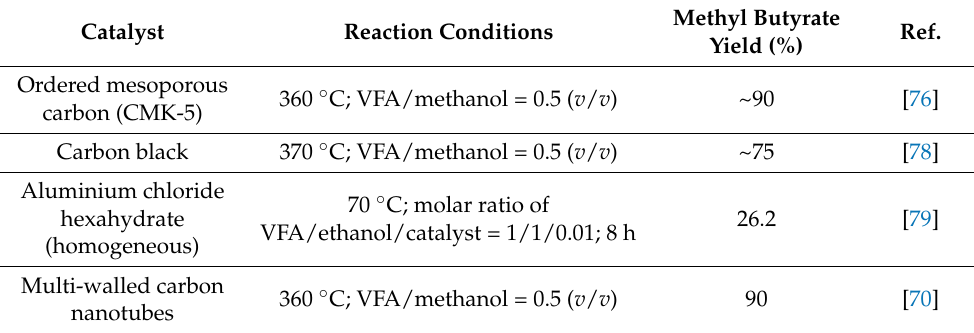
Table 2. Catalysts used for the esterification of butyric acid to methyl butyrate. All the results are obtained from earlier literature.